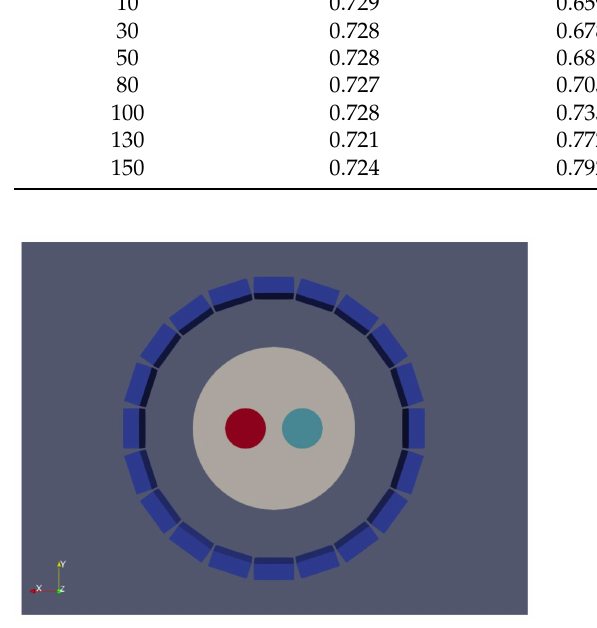
Figure 5. Simulation of Utah phantom. A rod with 10:1 activity (left, red) with respect to the external cylinder and a rod without activity (right, cyan) were